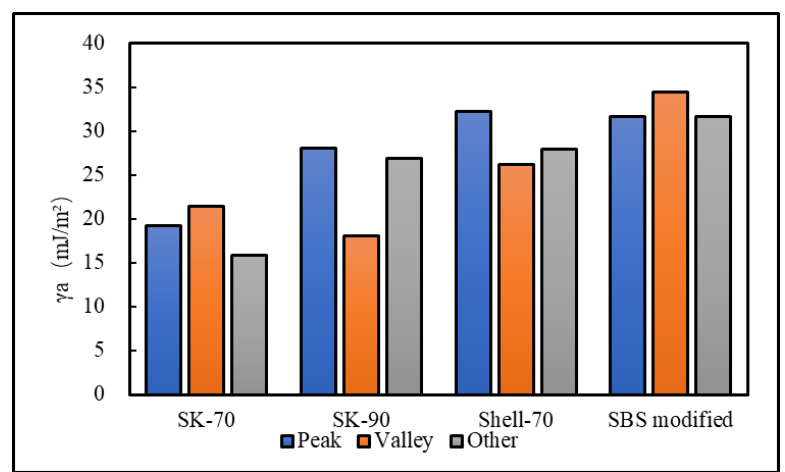
Figure 16. Surface energies of different regions of the soaked asphalts.